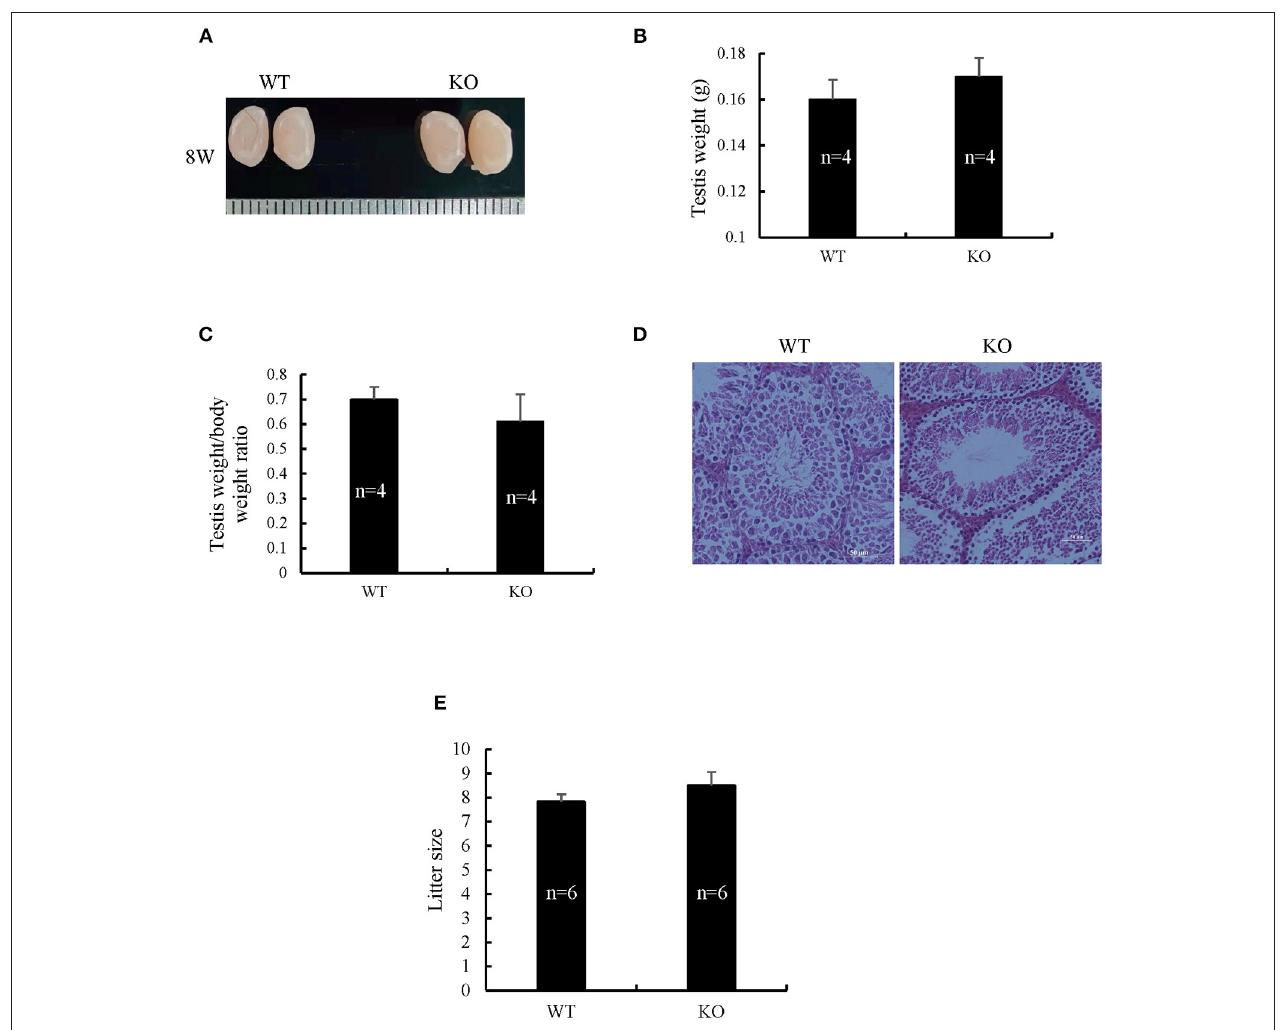
FIGURE 5 | Morphological analysis of Sugp2 knockout mouse. (A) Size of adult testes from wild-type (WT) and Sugp2 KO mice. Testis weight (B) and the ratio of testis to body (C) from WT and Sugp2 KO mice. Error bars represent standard error. (D) Hematoxylin and eosin (H&E) staining of adult testes in WT and Sugp2 KO mice. Scale bar = 50 µ m. (E) Comparison of litter size from wild-type and Sugp2 knockout mice.